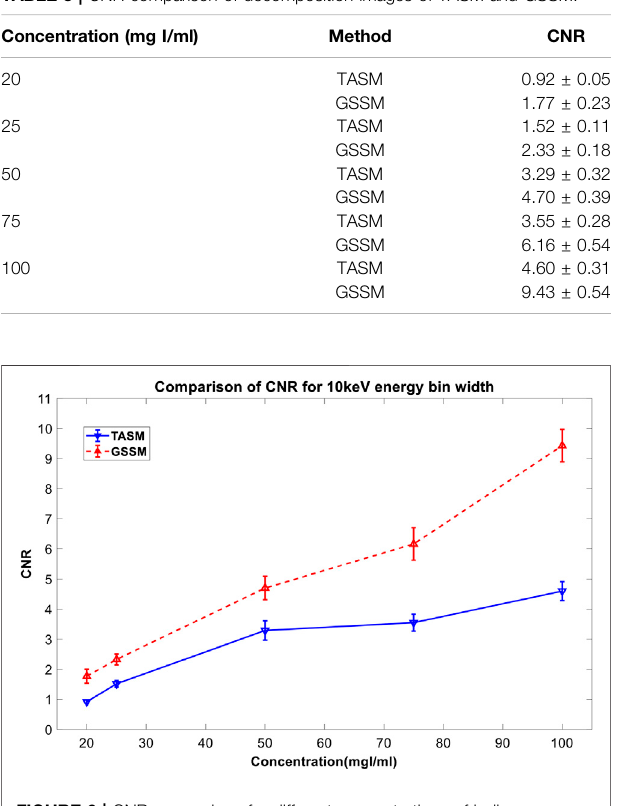
FIGURE 9 | CNR comparison for different concentrations of iodine contrast agents in Figure 8 . The blue line is the CNR result of TASM; the red dashed line is the CNR result of GSSM.